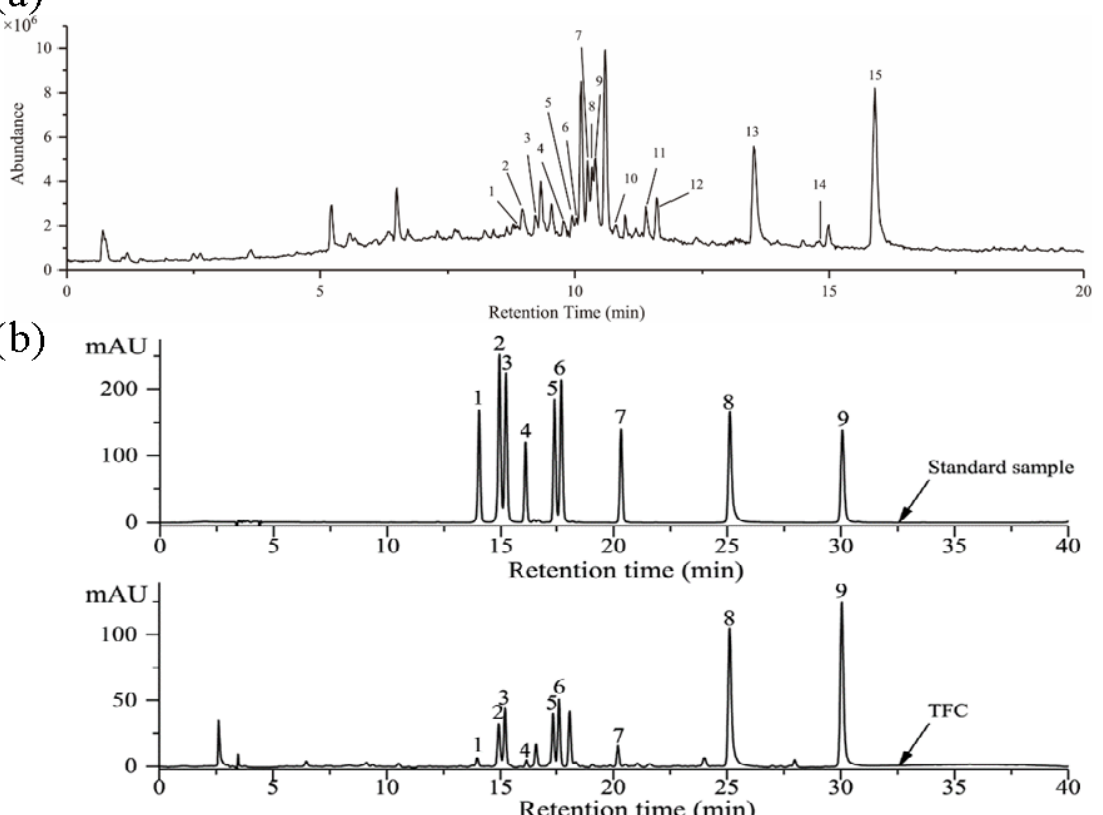
Figure 1. ( a ) The total ions chromatogram of the TFC. Rutin (1); Hyperin (2); Isoquercitrin (3); Kaempferol-3-O-rutinoside (4); Luteolin-5-O-glucoside (5); Quercetin-3-O-xyloside or Quercetin pentoside (6); Kaempferol-3-O-galactoside (7); Astragalin (8); Quercetin-3-O- α -L-rhamnoside (9); Kaempferol-3-O-arabinoside (10); Kaempferol-3-O-acetyl-galactoside (11); Afzelin (12); Quercetin (13); Naringenin (14); Kaempferol (15). ( b ) HPLC chromatographic of standard samples and TFC. Rutin (1); Hyperin (2); Isoquercitrin (3); Kaempferol-3-O-rutinoside (4); Luteolin-5-O-glucoside (5); Astragalin (6); Afzelin (7); Quercetin (8); Kaempferol (9). Table 2. Negative-ion ESI mass spectra of the main constituents of the TFC. No.